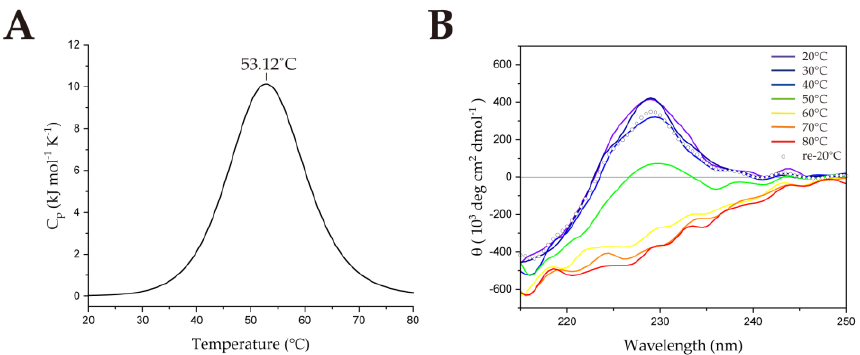
Figure 7. Thermostability of SsoSSB 12–114 . ( A ) Melting temperature of SsoSSB 12–114 measured by differential scanning calorimetry. ( B ) Circular dichroism spectroscopy was used to investigate the effect of temperature on the secondary structure of SsoSSB 12–114 .